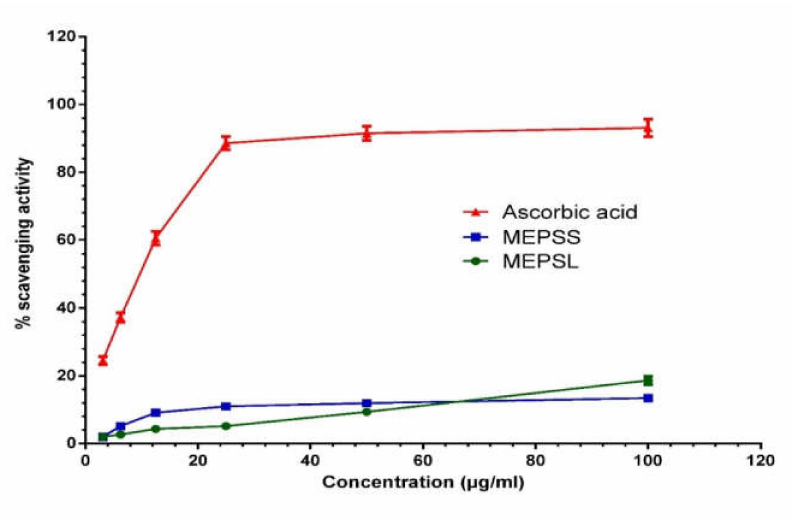
Figure 1. DPPH free radical scavenging activities of MEPSL and MEPSS compared with the reference standard ascorbic acid. Percentage of DPPH free radical scavenging activity by di ff erent concentrations of the MEPSL, MEPSS, and reference standard ascorbic acid. Values are expressed as mean ± SD ( n = 3). MEPSL, methanol extract of Piper sylvaticum leaves; MEPSS, methanol extract of Piper sylvaticum